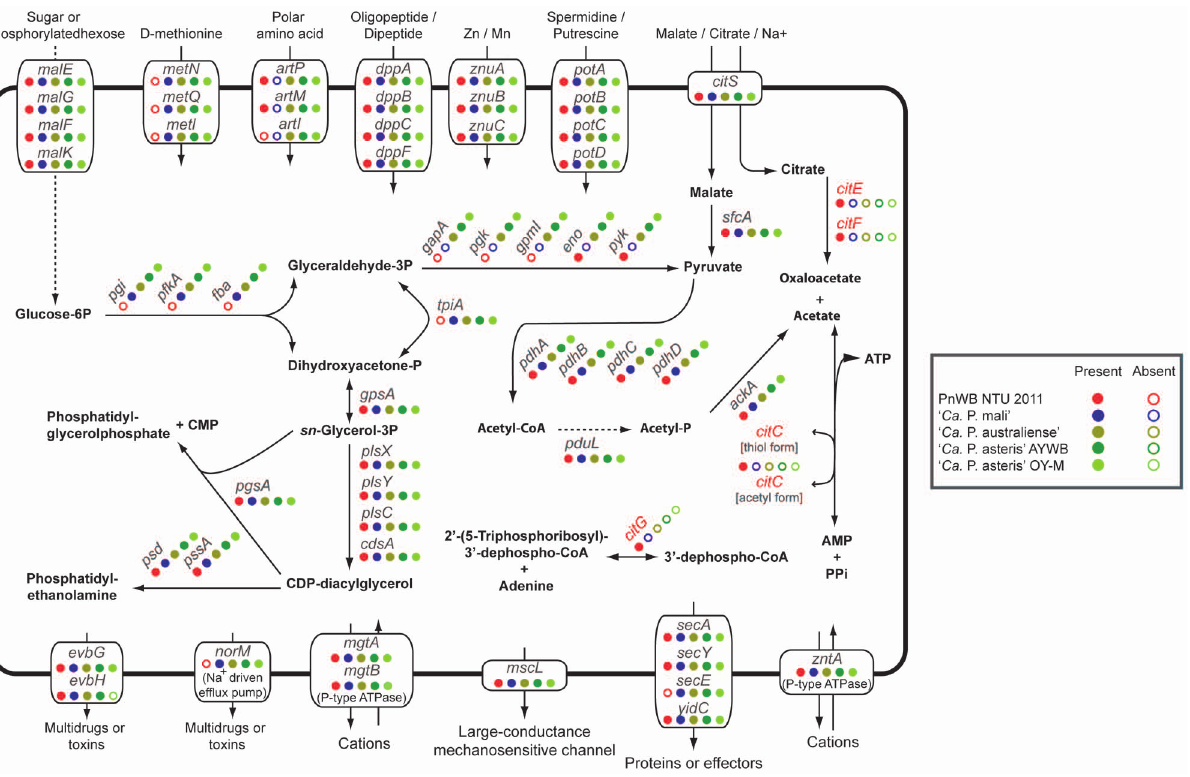
Figure 4. Highlights of selected metabolic pathways and transporters in phytoplasmas. The color-coded circles indicate the presence (filled) or the absence (unfilled) of a gene in each genome. Genes that are present in the PnWB phytoplasma and absent in the other four genomes are highlighted in red.